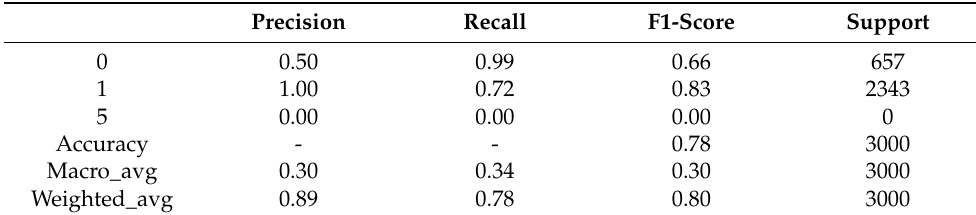
Table 1. Classification report for the existing system (CNN).